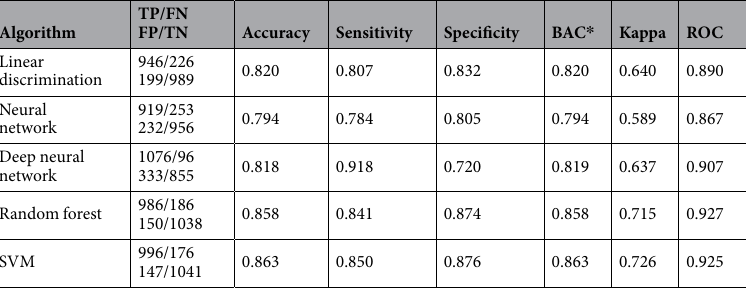
Table 2. Preliminary assessment of machine learning algorithms. * BAC: balanced